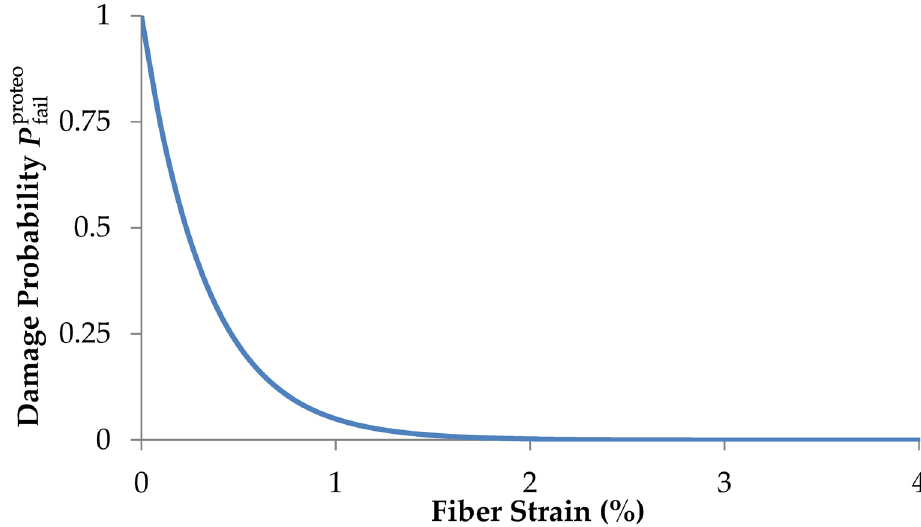
Fig 5. Probability function of fiber proteolytic damage as function of fiber strain. Fibers are completely shielded from proteolytic damage for peak fiber strains ε max (cid:6) 1.5%.